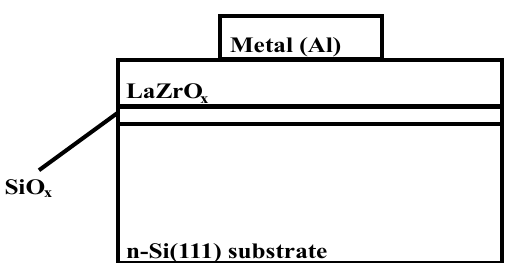
Figure 10. The fabricated structure of the sample tested in the experiment. SiO x was